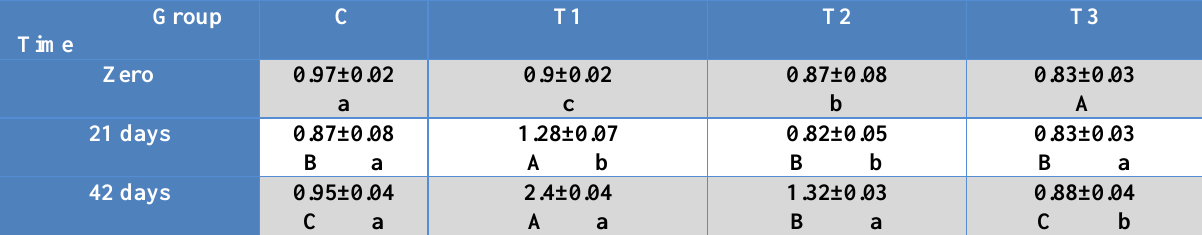
Table, 1: Effect of pomegranate seed oil (PSO), on Serum Creatinine concentration (mg/dl) in methionine treated adult female rabbits.